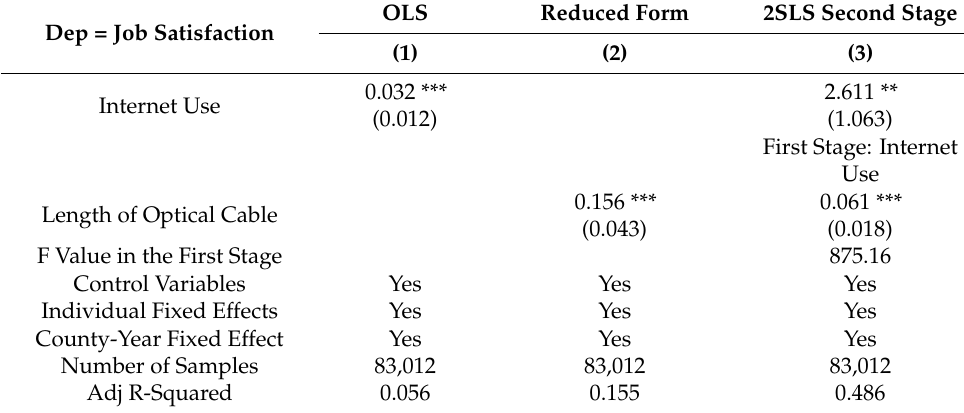
Table 6. Internet Use and Job Satisfaction: Instrumental